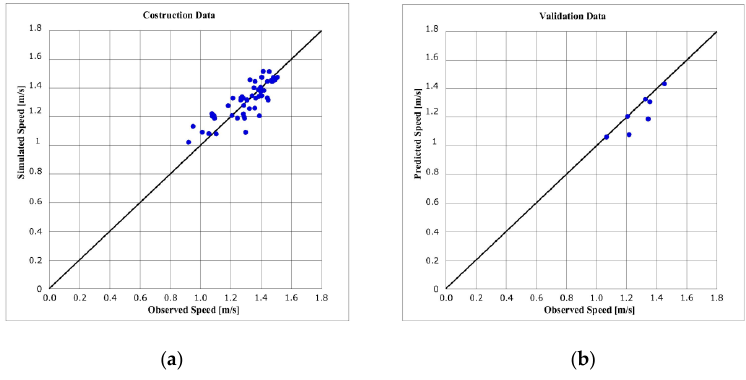
Figure 3. Comparison between the observed and estimated datasets: construction phase ( a ); and validation phase ( b ).